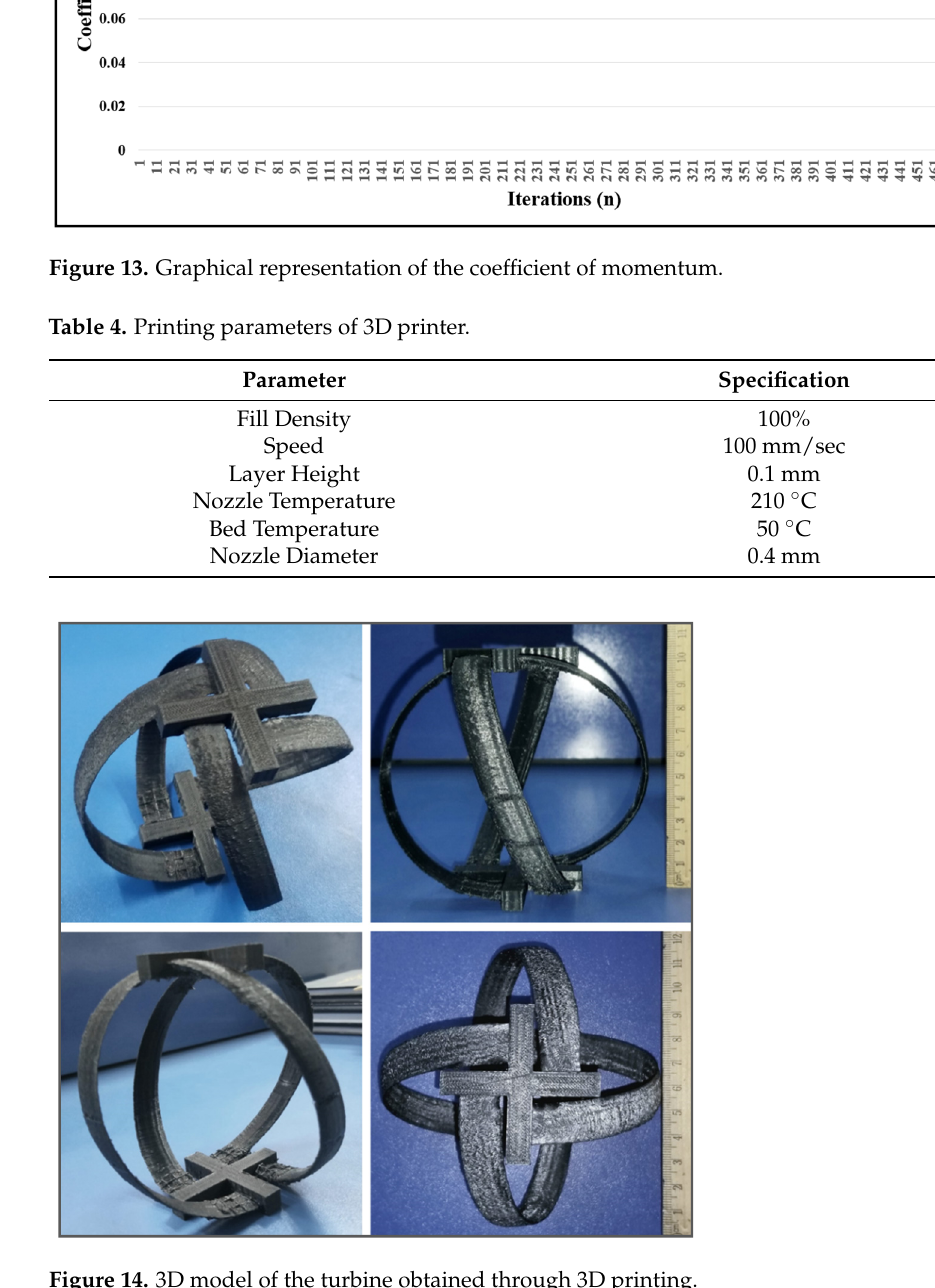
Figure 15. Prototype assembly and testing setup. 5. Results and Discussions 5.1. CFD Results CFD analysis in ANSYS Fluent 18.1 has provided various plots, contours, and path- lines to verify the feasibility and optimized operation of the turbine. Velocity pathlines of the turbine show that how the fluid particles have scattered after striking the blade surface and how the velocity of fluid particles have changed during the interaction. Velocity path- lines also show the direction of velocity by showing the scattered pattern of individual particles with respect to flow direction before impact. Figure 16 shows the velocity path- lines of the fluid after impact with the turbine. The decrease in velocity of the fluid right after impact is indicated by the pathlines.